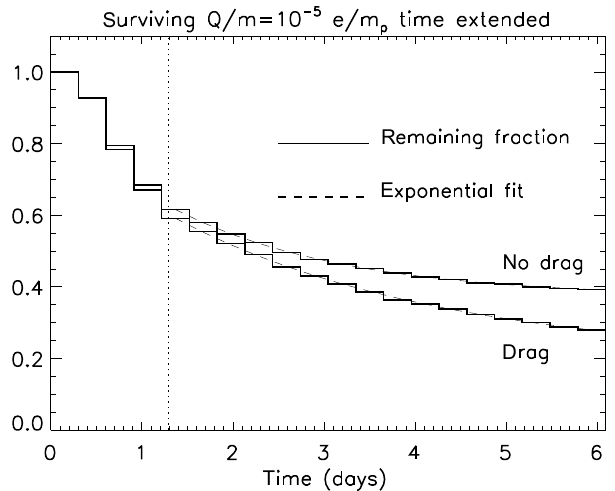
Figure 13. The fraction of particles remaining inside the calculation region as a function of time for the CME time-extended models with and without the ion drag. The vertical dotted line marks the end of the CME. The dashed lines shows the two parameter ( B and τ ) fits of the form (A − B) exp ( − t/τ) + B applied for the time period starting 1.32 days after the initial time. The best fits give B = 0 . 37 and τ = 1 . 87 days without drag and B = 0 . 19, τ = 2 . 9 days with